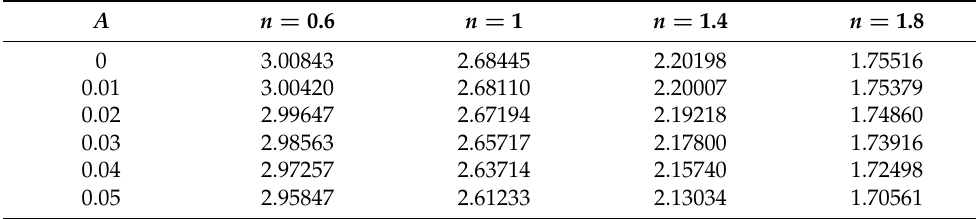
Table 10. The values of the average Nusselt number ( Nu avg ) at the heated boundary.